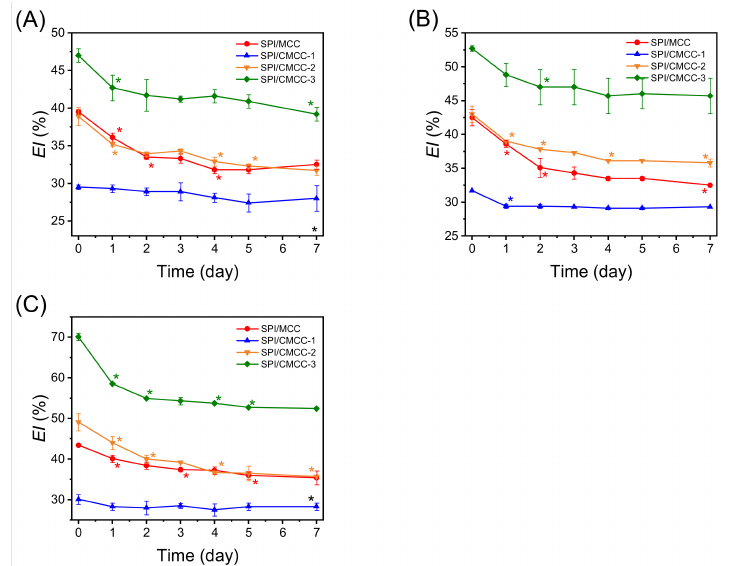
Figure 5. The emulsification index (EI) of the emulsion stabilized by complexes of SPI and MCC/CMCC at ratios of 3:1 ( A ), 1:1 ( B ), and 1:3 ( C ), * indicates significant difference from the previous data point ( p < 0.05).